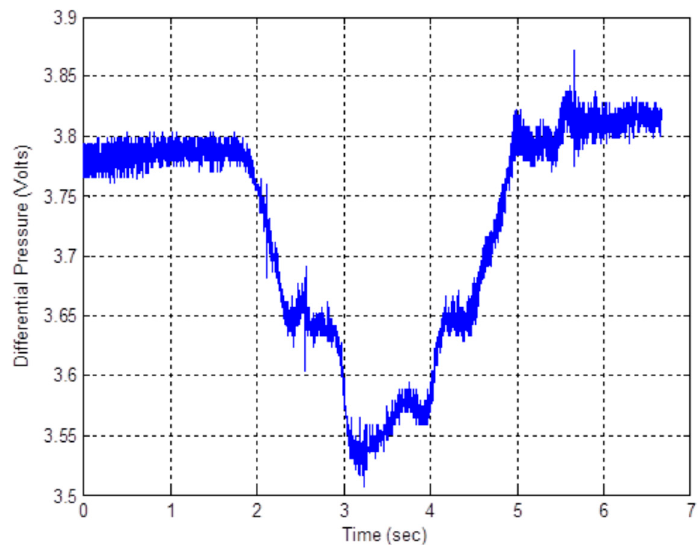
Figure 10. Raw data output by the di ff erential pressure transducer using an inflatable-matrass pump to provide the air flow.